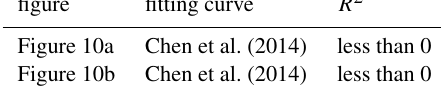
Table 5. Fitting effects of each curve in Fig. 10 on the observation points.